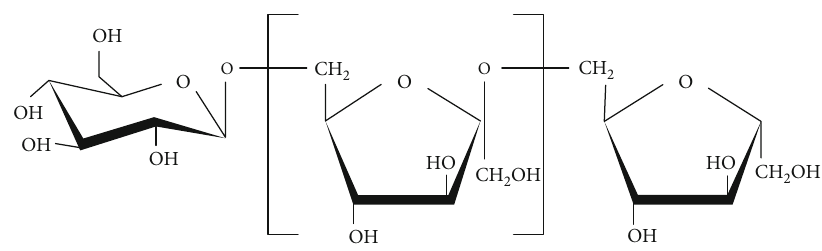
Figure 1: Chemical structure of